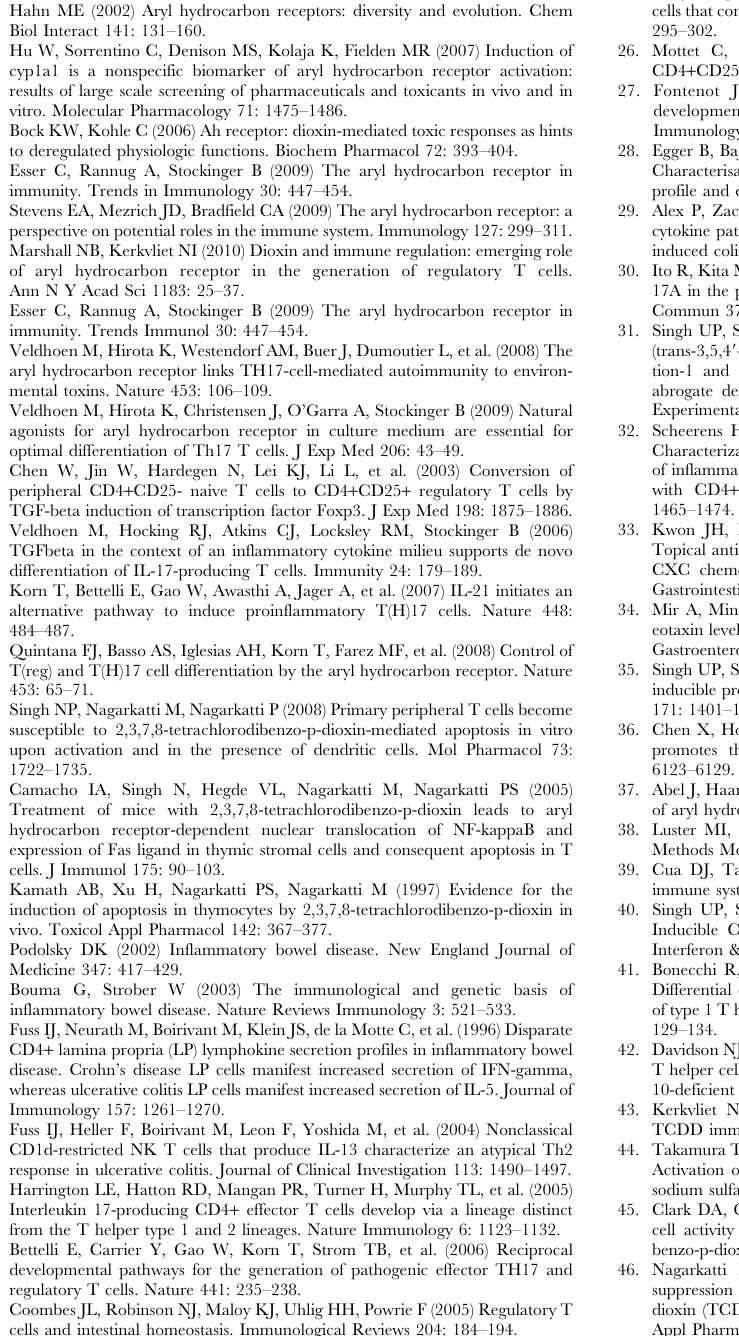
indicate statistically significant differences; i.e., p , 0.01 between DSS + VEH versus DSS + TCDD treated